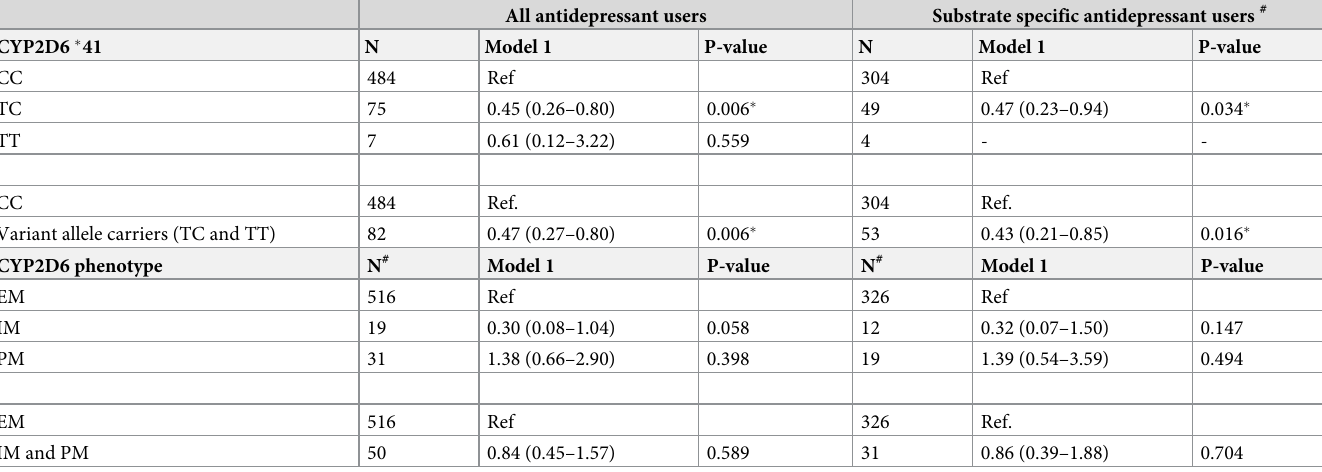
Table 2. Association between CYP2D6 � 41 and CYP2D6 � 41/ � 4 genotype and fall risk within antidepressant users. All antidepressant